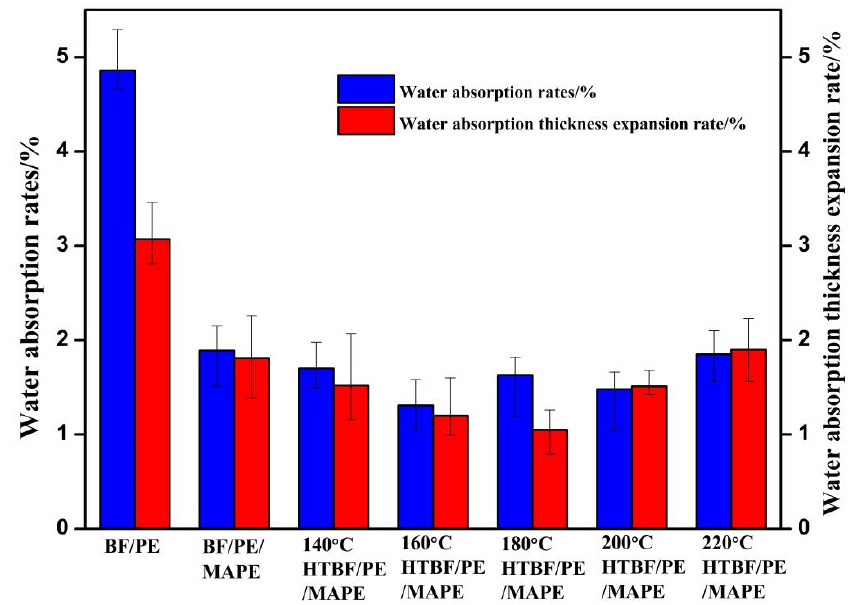
Figure 6. Influence of vacuum heat-treated bamboo fiber on the water absorption and the water absorption thickness expansion rate of bamboo plastic composite.